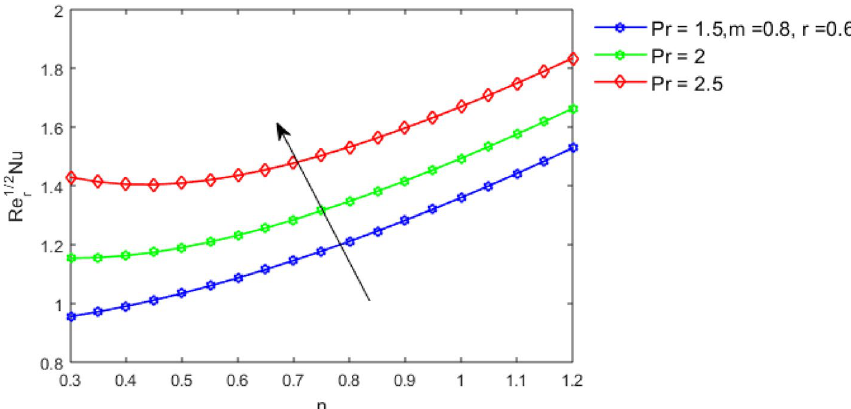
Figure 20. Heat transfer rate by increasing Pr, for n < 1, n = 1 and n > 1 .